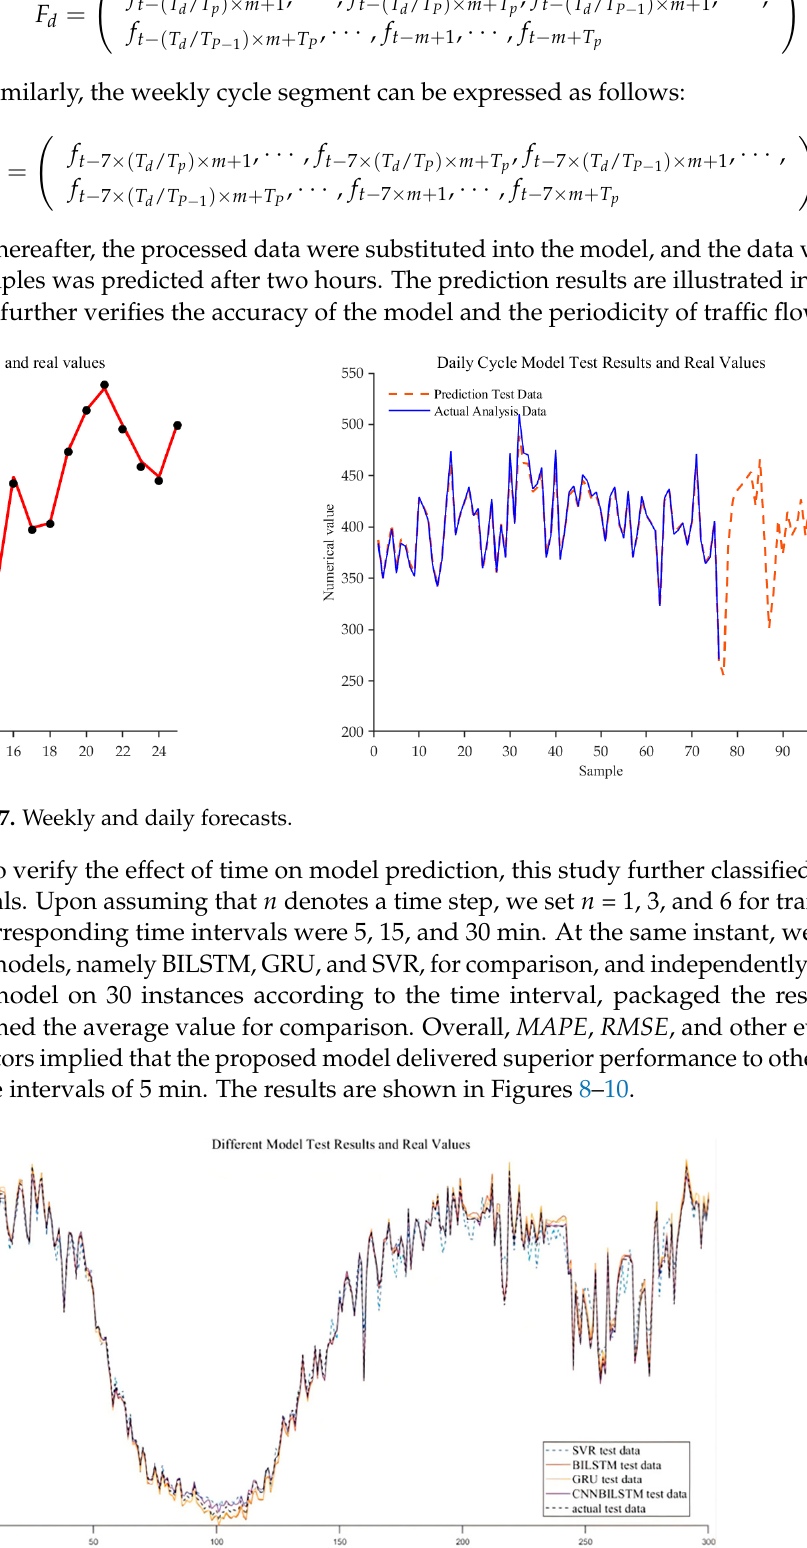
Figure 9. 15-minute forecast result graph. Figure 10. 30-minute forecast result graph.